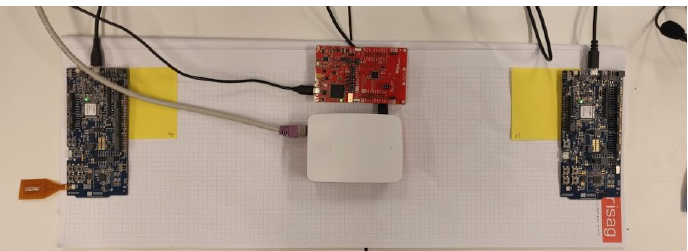
Figure 13. Practical measurement setup: on the left side an nRF52 central device, on the right side an nRF52 peripheral device, and in the middle a TI CC2652RB Sniffer.